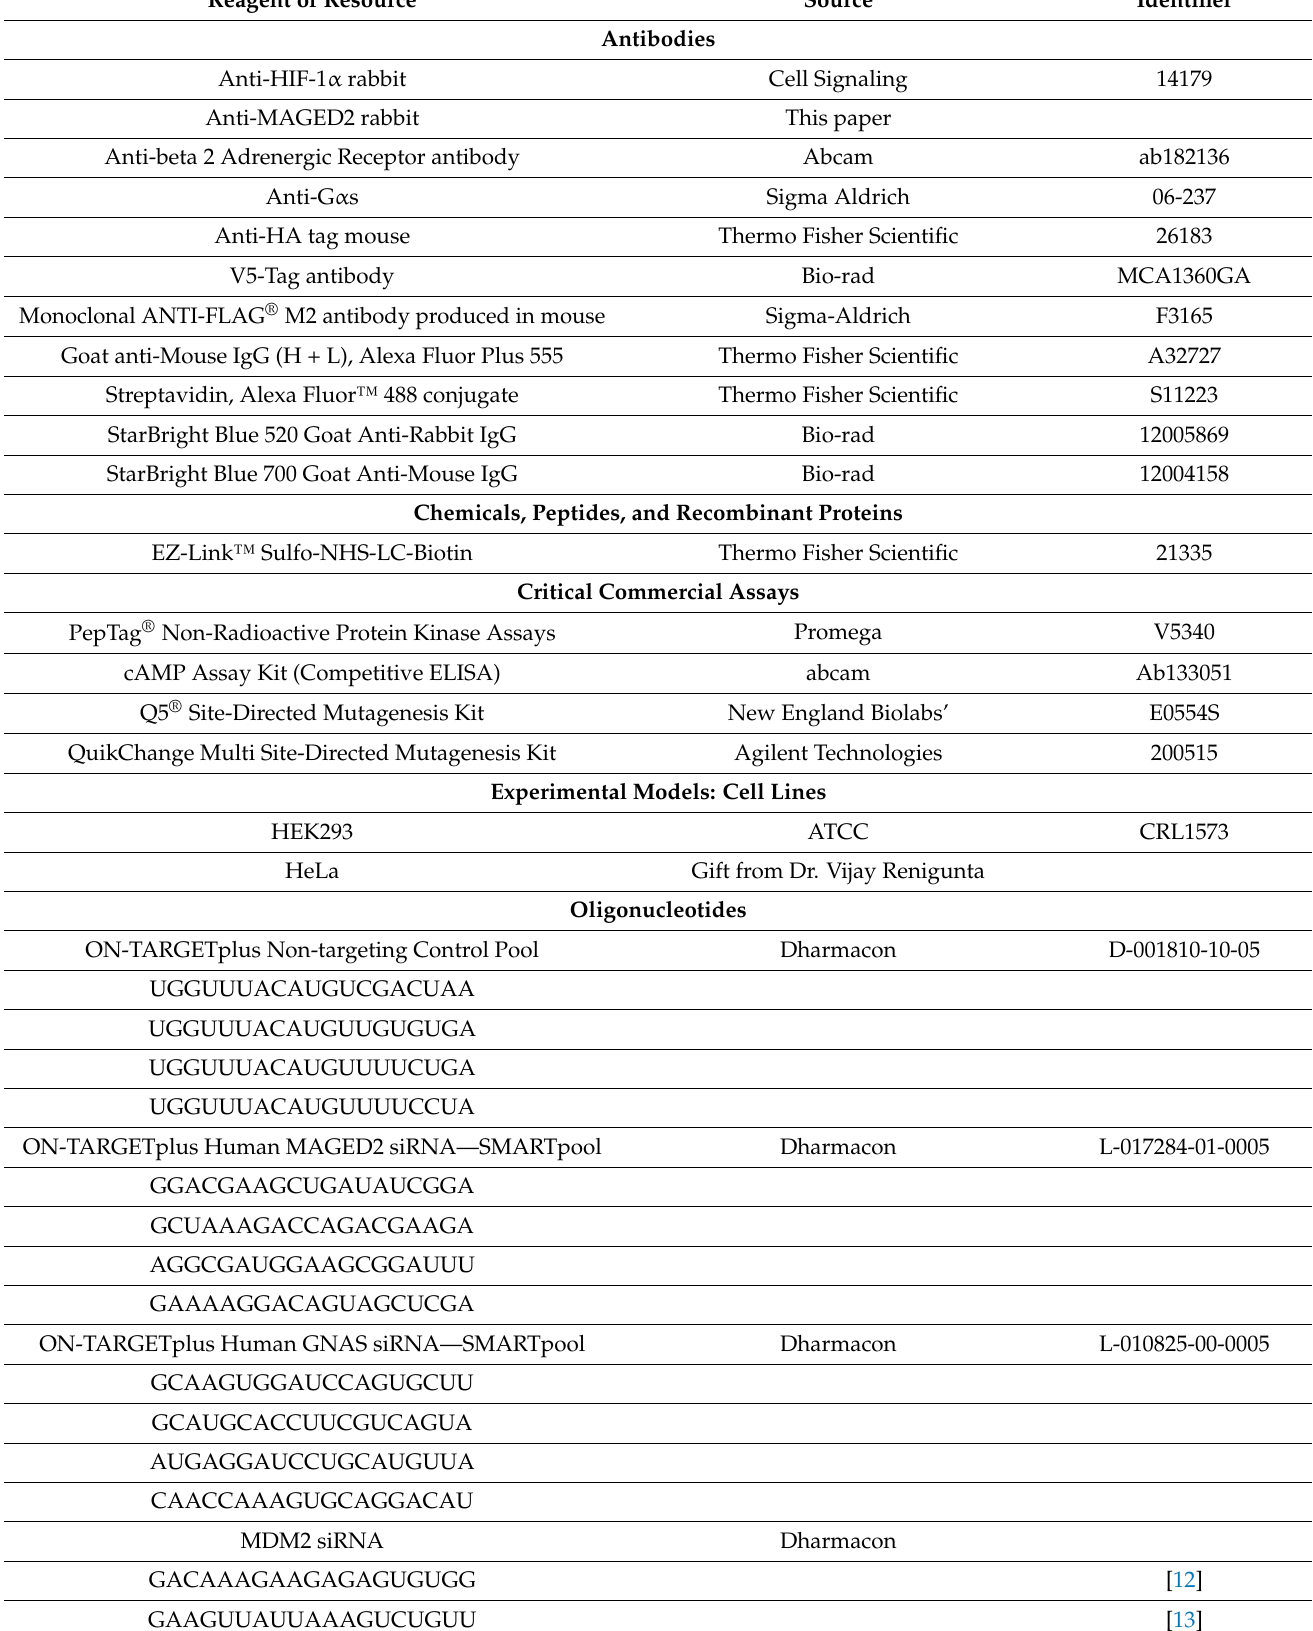
Table 1. Reagent and